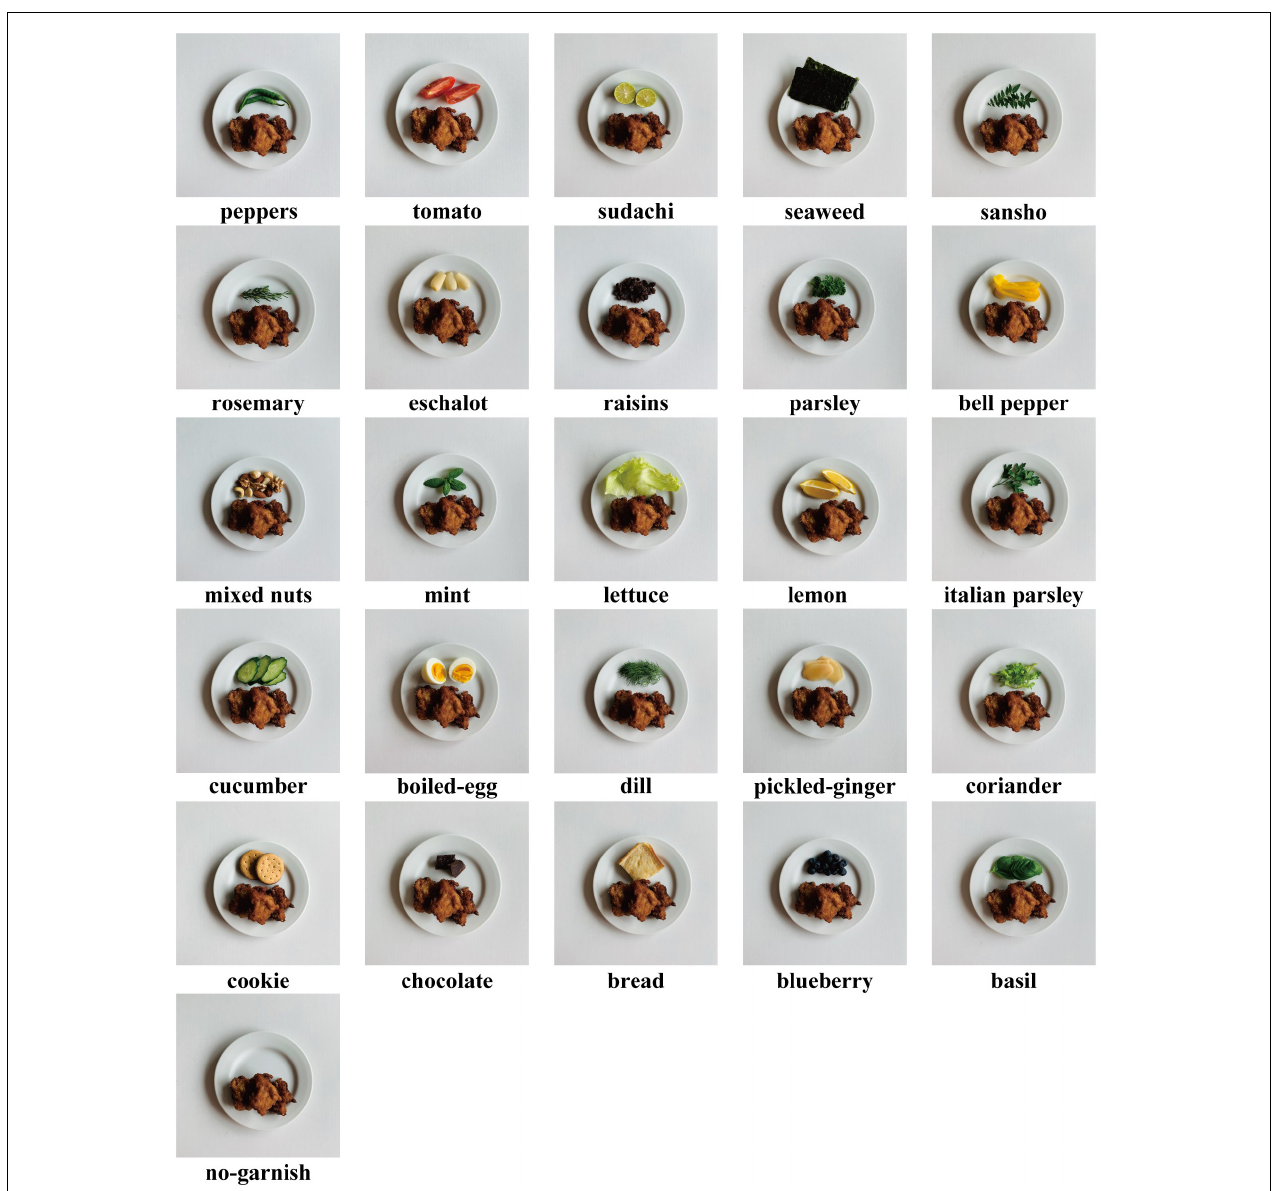
FIGURE 1 | Visual stimuli used in sensory evaluation experiments. We created 26 types of stimuli, including the no-garnish plate: unchanged plates and main dish (fried chicken). The ingredients were selected based on the results of a 10-participant pilot study with 30 types of garnish. Of these, 25 were chosen from the perspective of color, taste, and